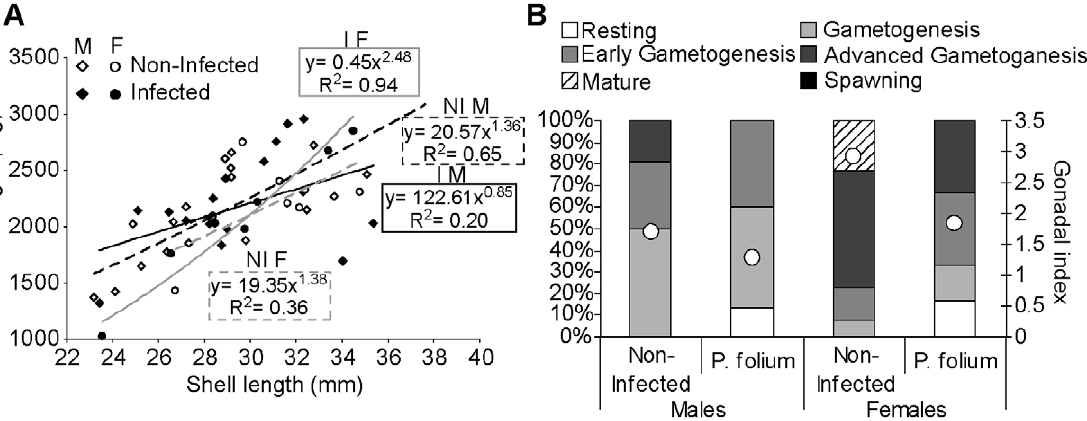
Figure 1. Allometric relationships and Reproductive status of zebra mussels infected or not by P.folium . Allometric relationships of shell length (cm) and total weight (i.e. sum of shell and wet weights) (g) for male and females zebra mussels infected or not by P. folium ( A ). Full points: infected organisms (I), Empty points: non-infected organisms (NI). Solid line: allometric relationships for infected individuals (Black: males (M), Grey: females (F)), Dashed line: allometric relationships for the non-infected (Black: males (M), Grey: females (F)). Percentages of mussels at each gamete developmental stage and gonadal index values (white dots) ( B ), in function of the mussel gender and the infection status.